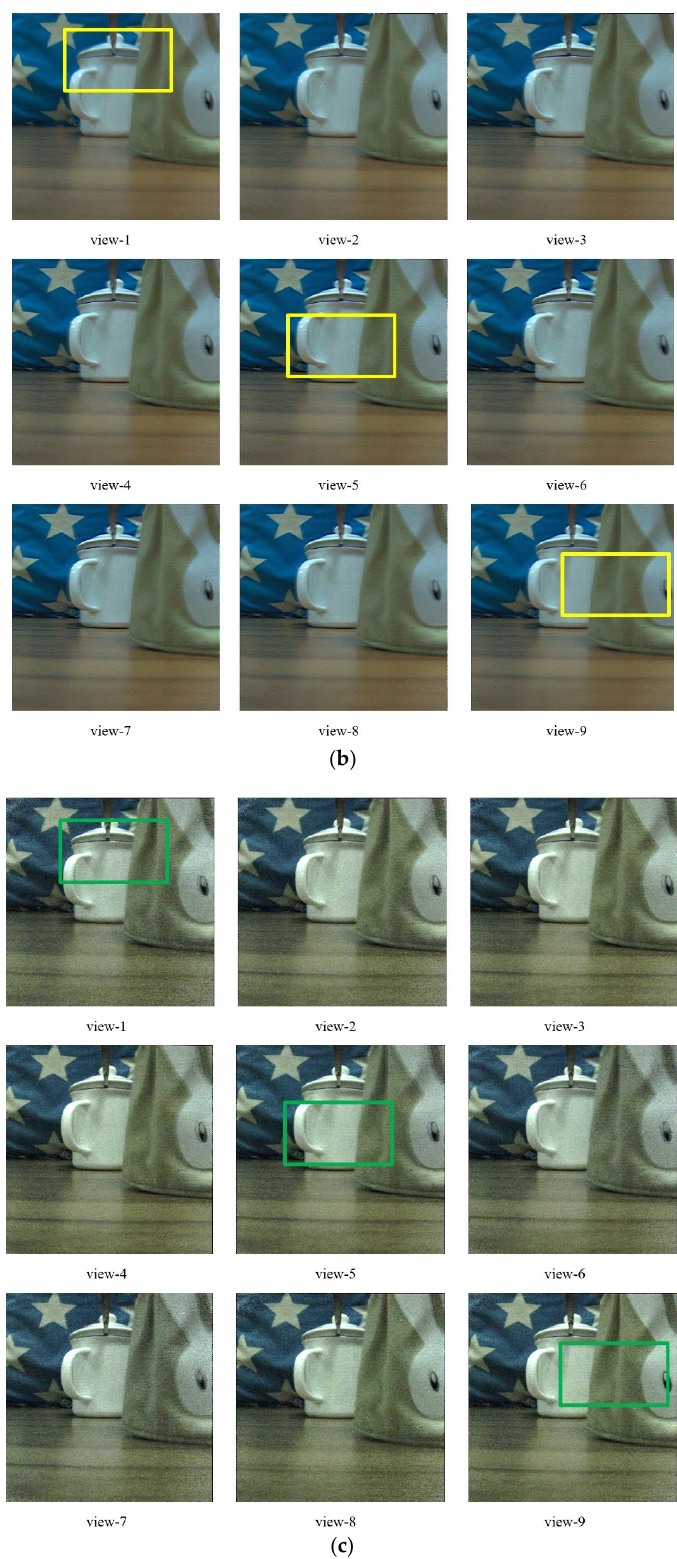
Figure 10. Comparative result images. ( a ) Extracted view angle image based on the proposed aperiodicity method with the proposed LC microlens; ( b ) the corresponding weighted average result images of ( a ); ( c ) extracted view angle image based on the conventional periodicity method with the conventional LC microlens. To present much more details, those images have been magnified to a certain extent.